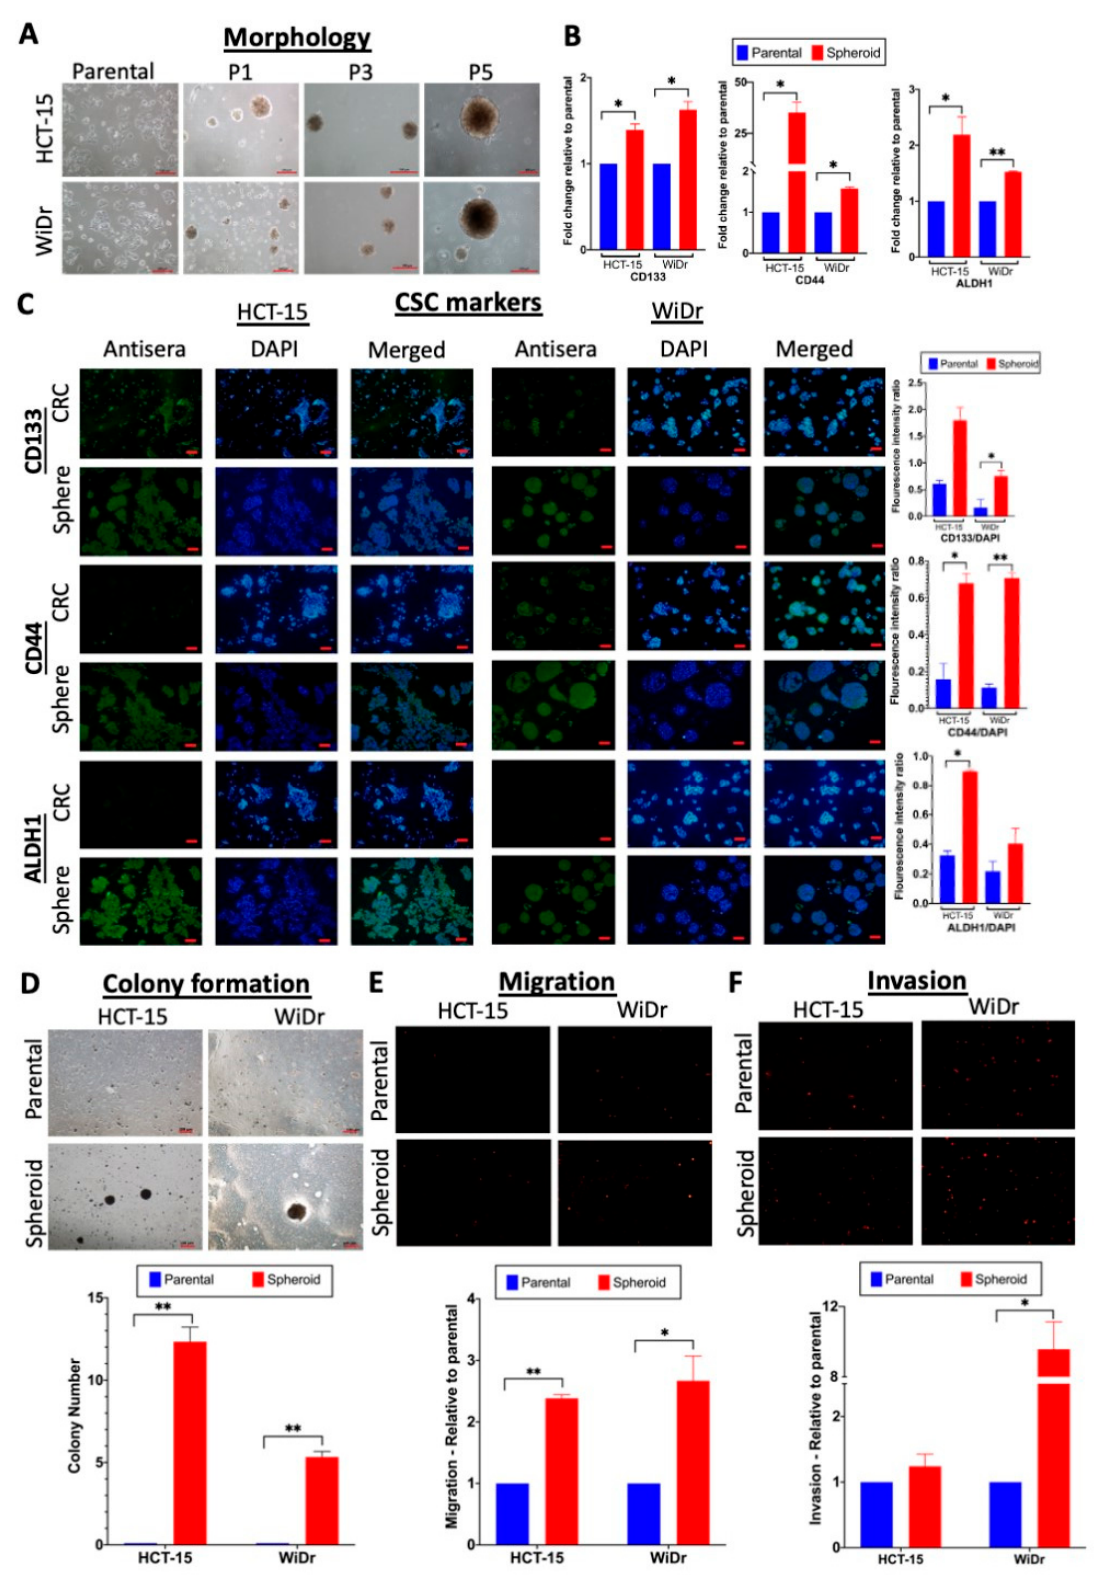
Figure 1. Generation of cancer stem cell (CSC)-enriched colorectal cancer (CRC) spheroid cells that showed enhanced stemness-related properties. ( A ) Morphology of CRC parental and spheroid cells at different passages (P) in the spheroid culture (bars: 100 μ m). ( B , C ) Up-regulated expression of CSC markers CD133, CD44 and aldehyde dehydrogenase 1 (ALDH1). ( B ) qRT-PCR analysis of CSC markers on parental and spheroid cells. Glyceraldehyde 3-phosphate dehydrogenase (GAPDH) was